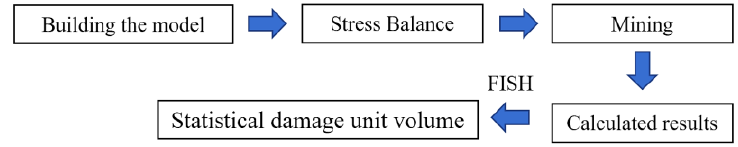
Figure 3. Numerical simulation calculation process.